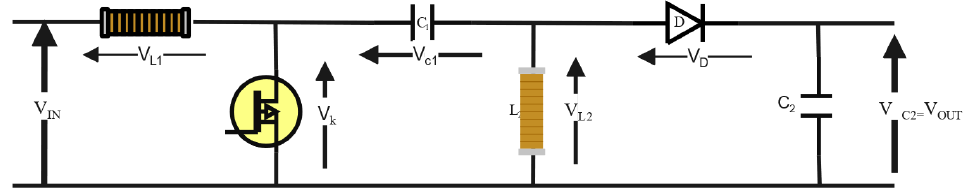
Figure 4. Electrical diagram of a SEPIC converter [28].